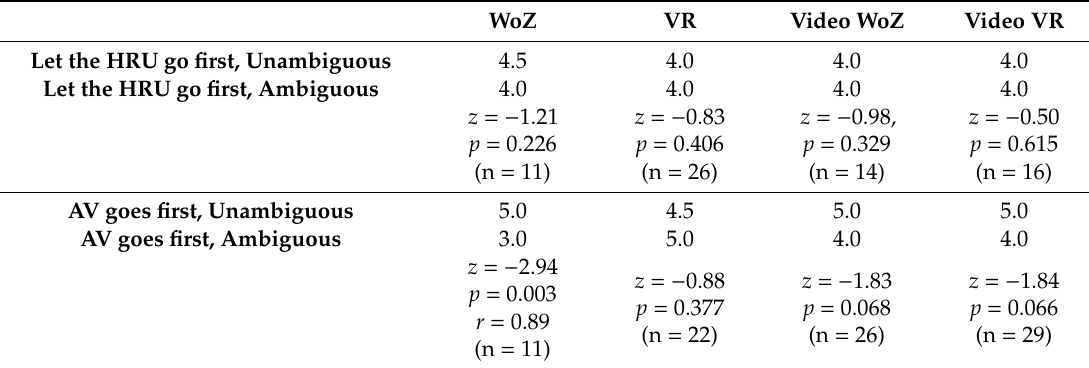
Table 10. Median ( Mdn ) of the subjective decision-making reliability (1 = very uncertain, 5 = very certain), segregated by